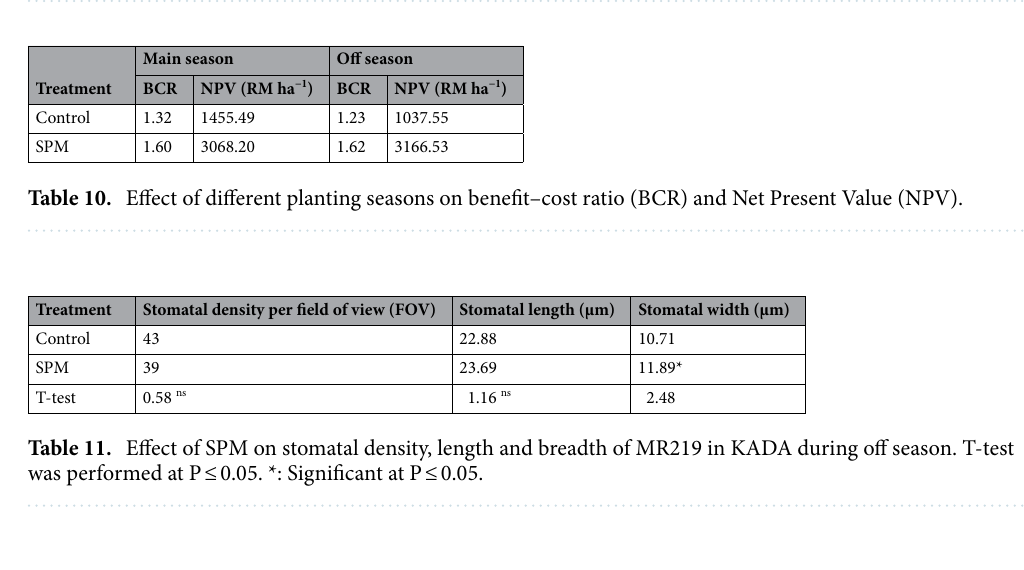
Figure 5. Effect of SPM treatment on yield production and monthly rainfall in rice plants during main and off seasons. Bars represent standard errors of means (n = 3). T-test was performed at P ≤ 0.05 (n = 4). *: Significant at P ≤ 0.05.